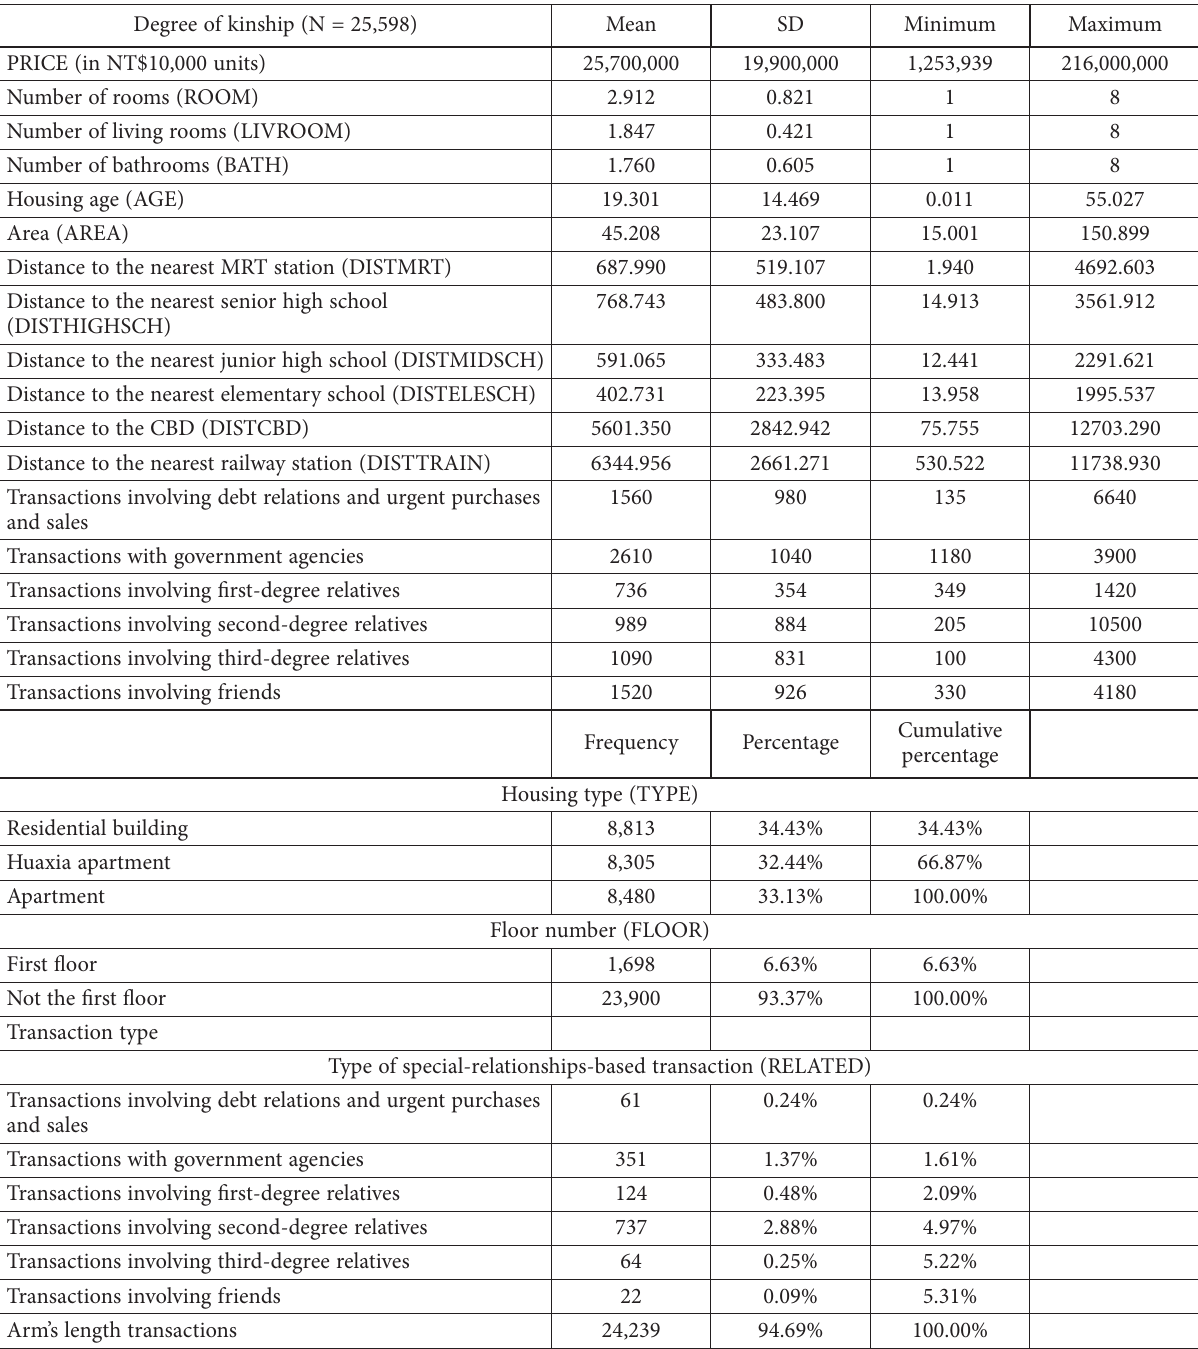
Table 3. Descriptive statistics of samples (in terms of degree of